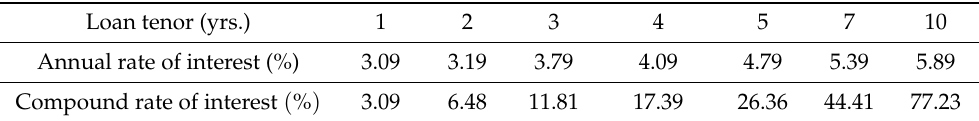
Table 1. Different loan tenors and their corresponding rates of interest. Loan tenor